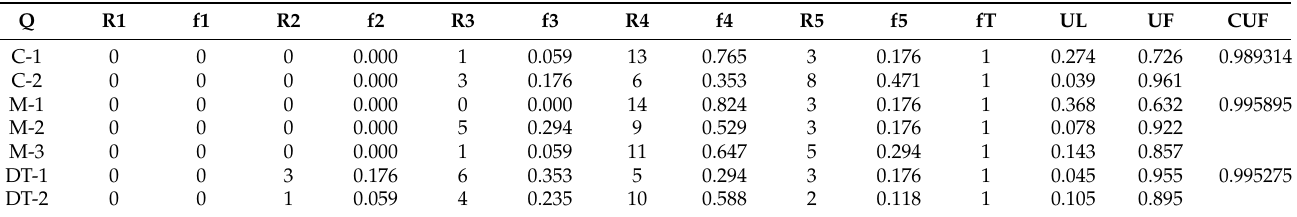
Table A1. Questions —categorization, frequencies, uncertainty level, and certainty factor per question and category.